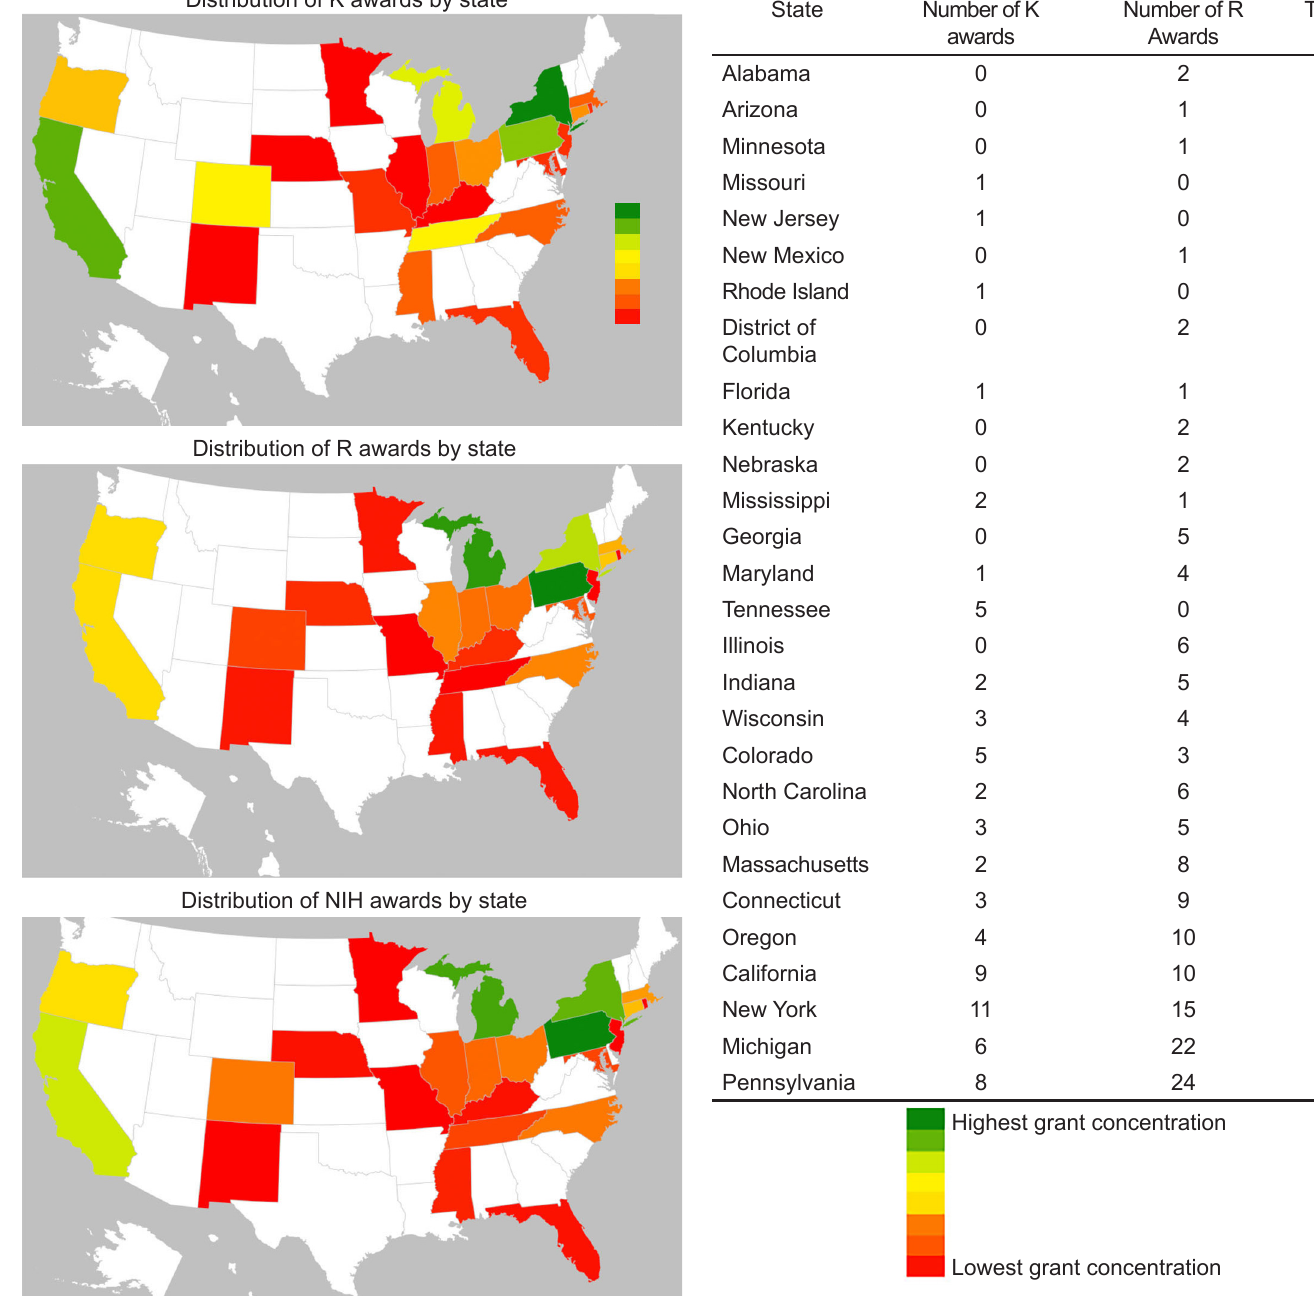
Figure 1. Geographical distribution of NIH awards across the United